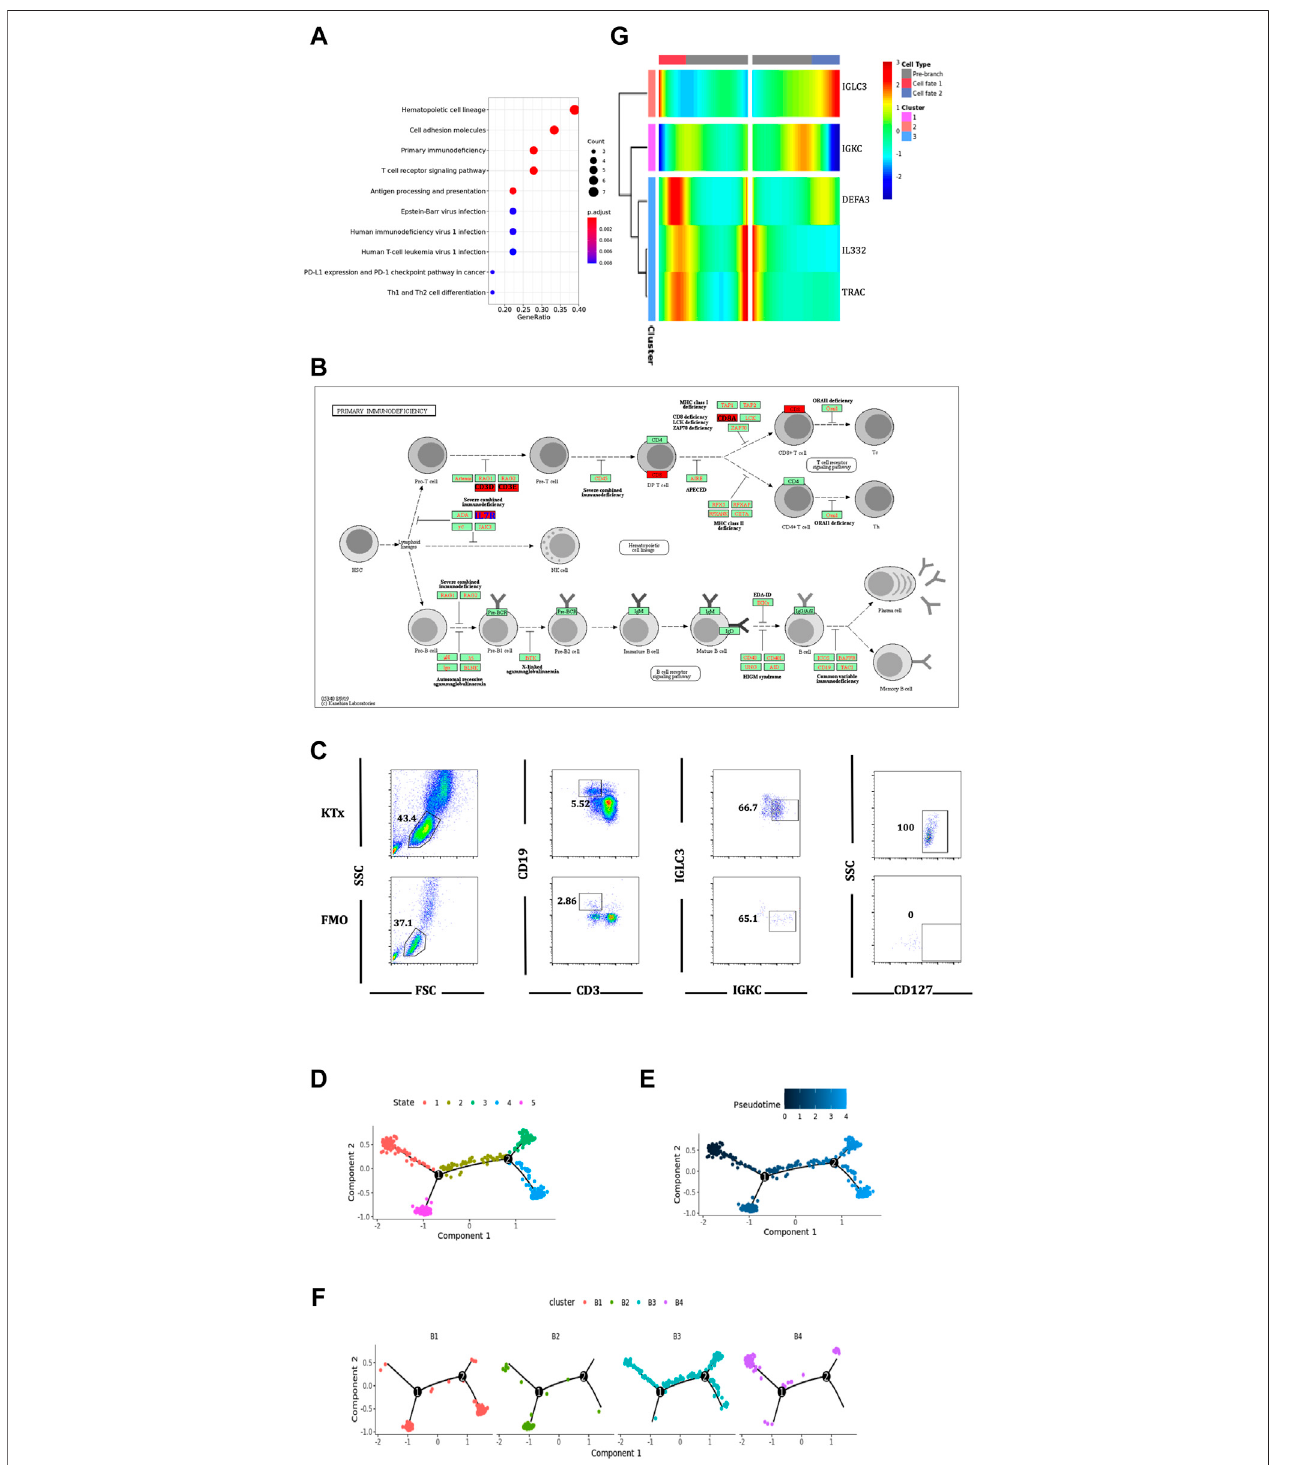
FIGURE 7 | Function and differentiation analysis of B4 cluster. (A) KEGG analysis of highly expressed genes on B4 cluster. (B) In the primary immunode fi ciency pathway, IL7R was the key gene. (C) Flow cytometric analysis of CD19 + IGKC + IGLC - CD127 + B cells from lymphocytes in KTx group. (D – F) Packages monocle2 was used for pseudotime analysis of B-cell subset differentiation. (G) BEAM analysis of B4 cluster fate point.